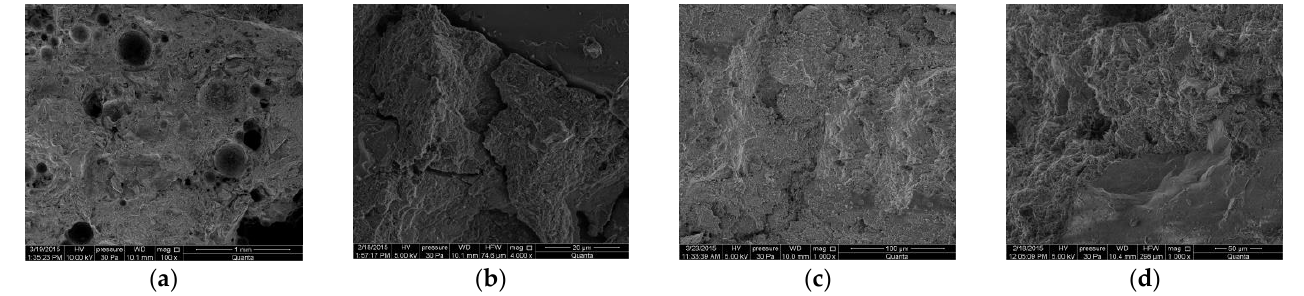
Figure 15. Photos of the microstructure of concrete taken from the cover layer of the tested samples: ( a ) C_I_a, ( b ) C_I_n, ( c ) C_III_a, ( d ) C_III_n.